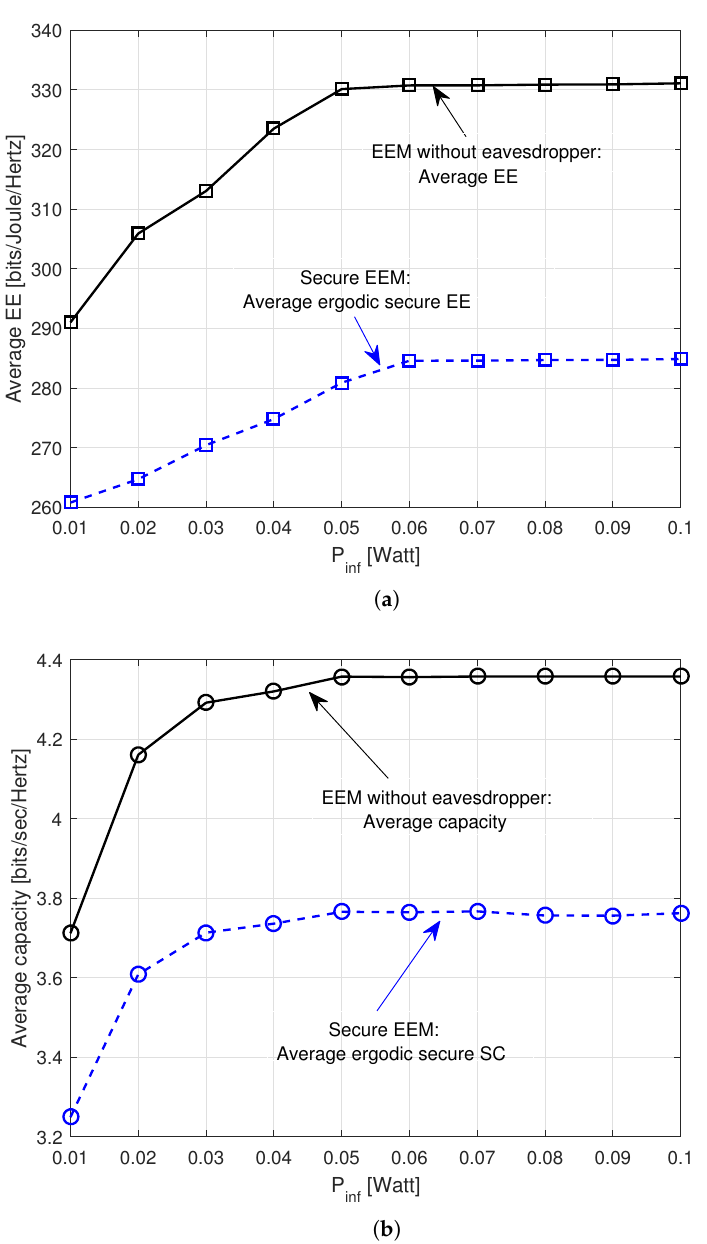
Figure 6. Average ergodic secure EE and SC of SU versus average capacity of the network with- out eavesdropper. ( a ) Average ergodic secure EE of SU versus P inf , ( b ) Average ergodic secure EE and SC of SU versus P inf